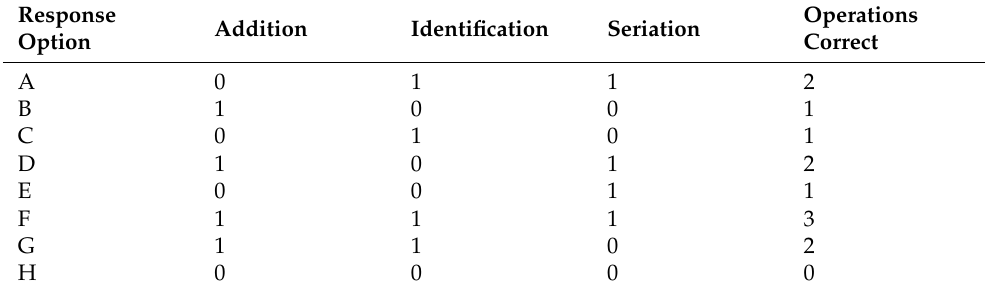
Table 2. Distractors and their correct/incorrect setup of underlying operations for the example item.